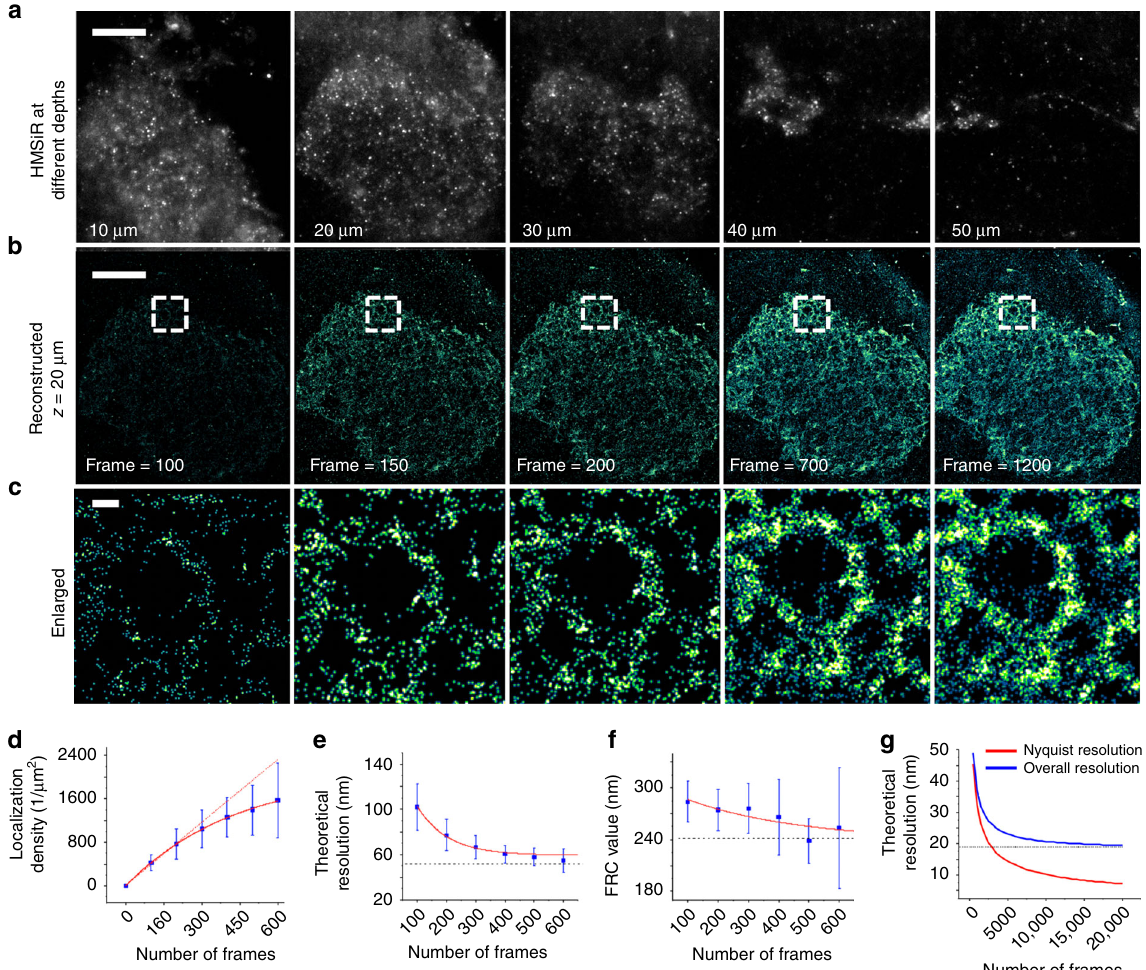
Fig. 3 Super-resolved three-dimensional neuron images in D. melanogaster . a At different imaging depth, the blinking signals of HMSiR were imaged through the volumetric scan of lightsheet. b Super-resolution image of neuron at speci fi c imaging depth were reconstructed with different length of time- lapse images, which corresponds to different localization density. c An enlarged region of interest (white box) in b is shown to compare the increased resolution resulted from the higher localization density. d Localization density increases exponentially with respect to the number of frames used in reconstruction. As the number of frames reaches 600, the growth of the localization density reaches a plateau due to the depletion of fl uorophore and photobleaching. A linear increase was noted in the localization density (red dotted line), assuming unlimited photons budget is drawn for comparison. e The theoretical resolution increased rapidly at the beginning. No signi fi cant increase was noted with the number of frames exceeding 400 and the lateral resolution at about 60 nm. f Fourier ring correlation (FRC) analysis of the localized molecules expressed in a fl y ’ s olfactory projection neuron. The decrease in FRC value at 1/7th cut-off frequency is shown with respect to the number of frames. g The estimation of Nyquist and overall resolution assuming a linear increase of localization density (no photobleaching and the depletion of fl uorophores present). Scale bar = 20 μ m in ( a , b ), 1 μ m in ( c ). Each value represents mean ± S.D. ( n = 4). Source data are provided as a Source Data fi vertical lobe (sectors α 2, α ′ 2) had the highest innervation density (Fig. 5d). By applying the defocusing PSF model during post-processing of the data (Supplementary Note 1; Supplementary Figs. 8 and 9), digital segmentation of individual neurons, with nominal axial overlap, was achieved in a whole-brain 3D image (Fig. 5e, f). Serial optical slices and 3D navigation demonstrated extensive yet separable neurites (Supplementary Movie 4).